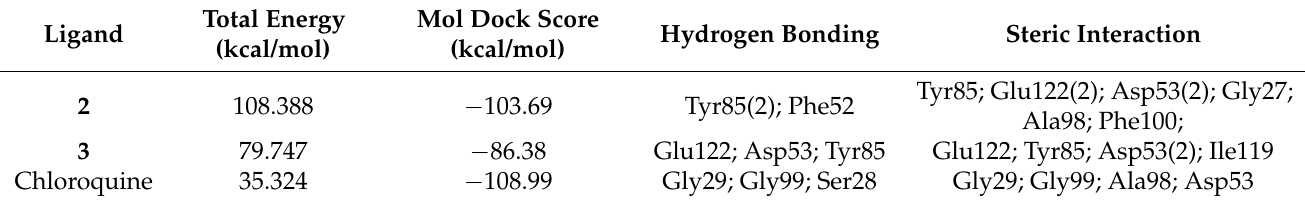
Table 7. The total energy, MDS, and interacting residues of 2 and 3 to P. falciparum lactate dehydrogenase enzyme (1CET).